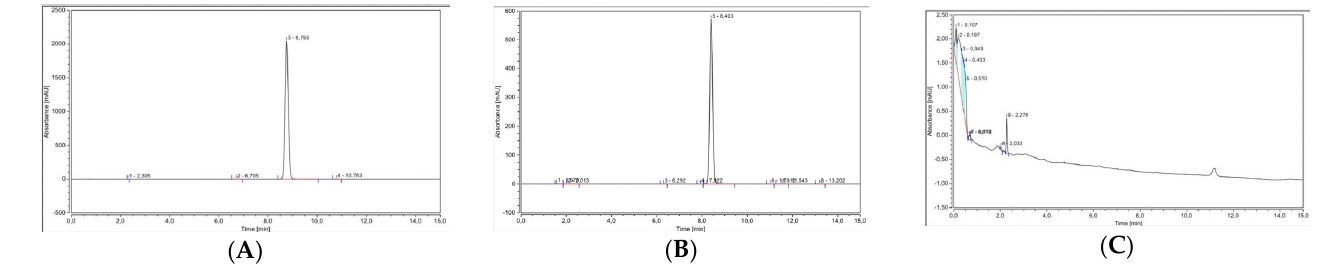
Figure 2. Chromatogram and spectrum of ketoprofen as determined by HPLC. ( A ) Ketoprofen standard. ( B ) Ketoprofen − PVA mixture. ( C ) Blank sample. Table 1. Coefficient of determination (R 2 ) of the calibration curves, limit of detection (LOD), and limit of quantification (LOQ) of the HPLC method for ketoprofen.